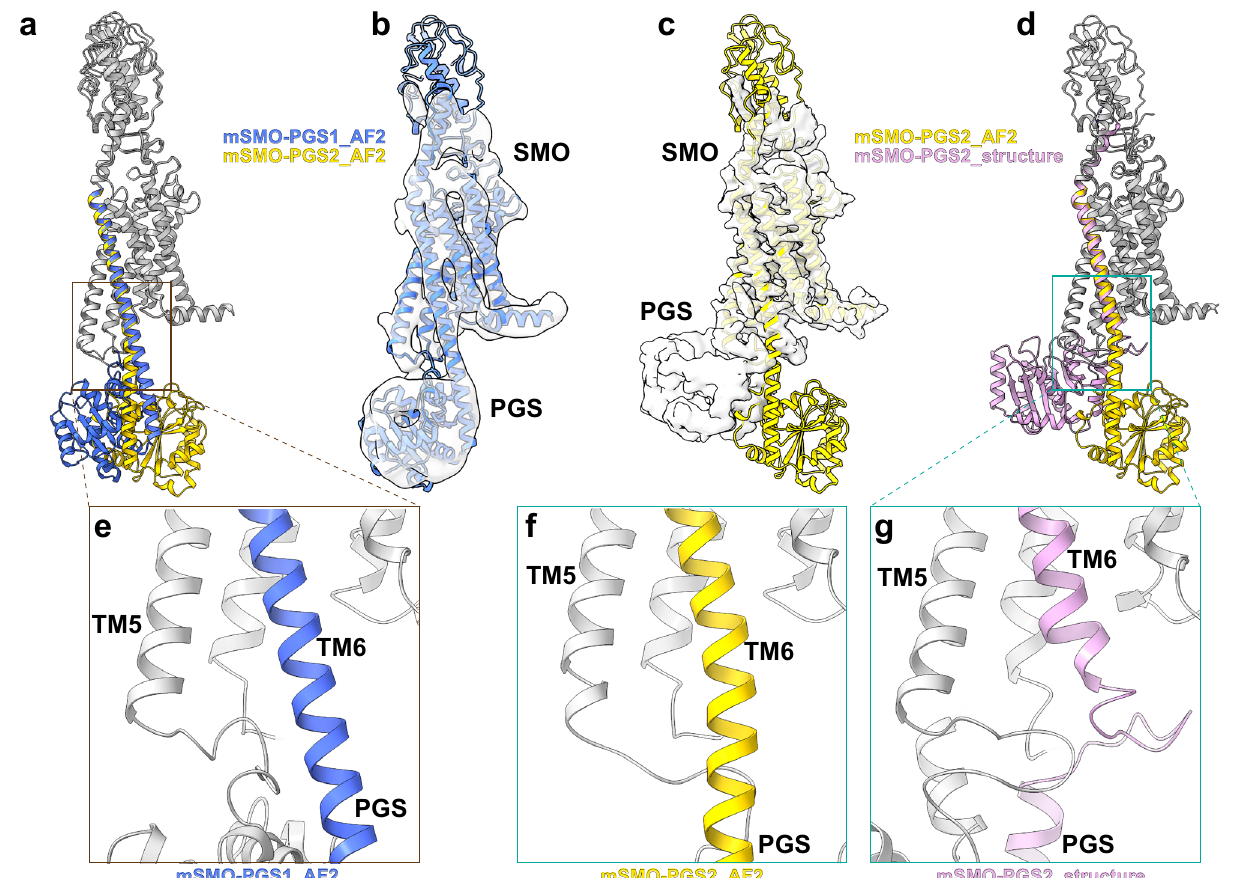
Fig.2|Single-particlecryo-EMstructuresofmSMO-PGS.a Theatomicmodelsof mSMO-PGS1 (blue) and mSMO-PGS2 (yellow) predicted by alphaFold2 (AF2). Note that the inserted PGS are predicted to be oriented in two opposite directions in these two constructs. b Cryo-EM density determined from mSMO-PGS1, docked with the atomic model predicted by AF2 (blue ribbon). c Cryo-EM density